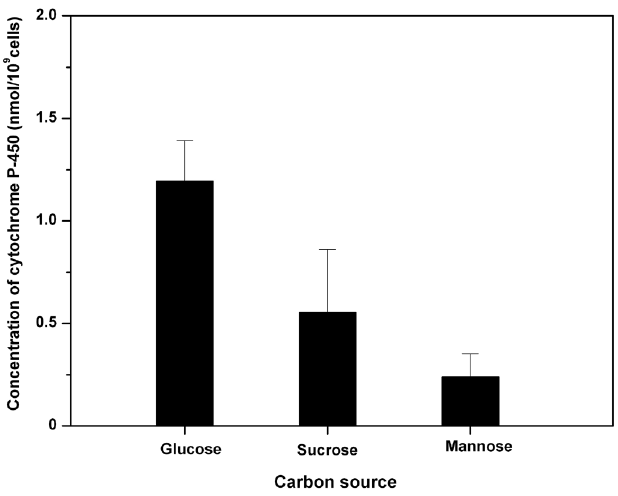
FIGURE 2 - Cytochrome P-450 production by S. cerevisiae strain ATCC 9080 cultured for 12 h in media containing glucose, sucrose, and mannose, at concentrations of 2 %